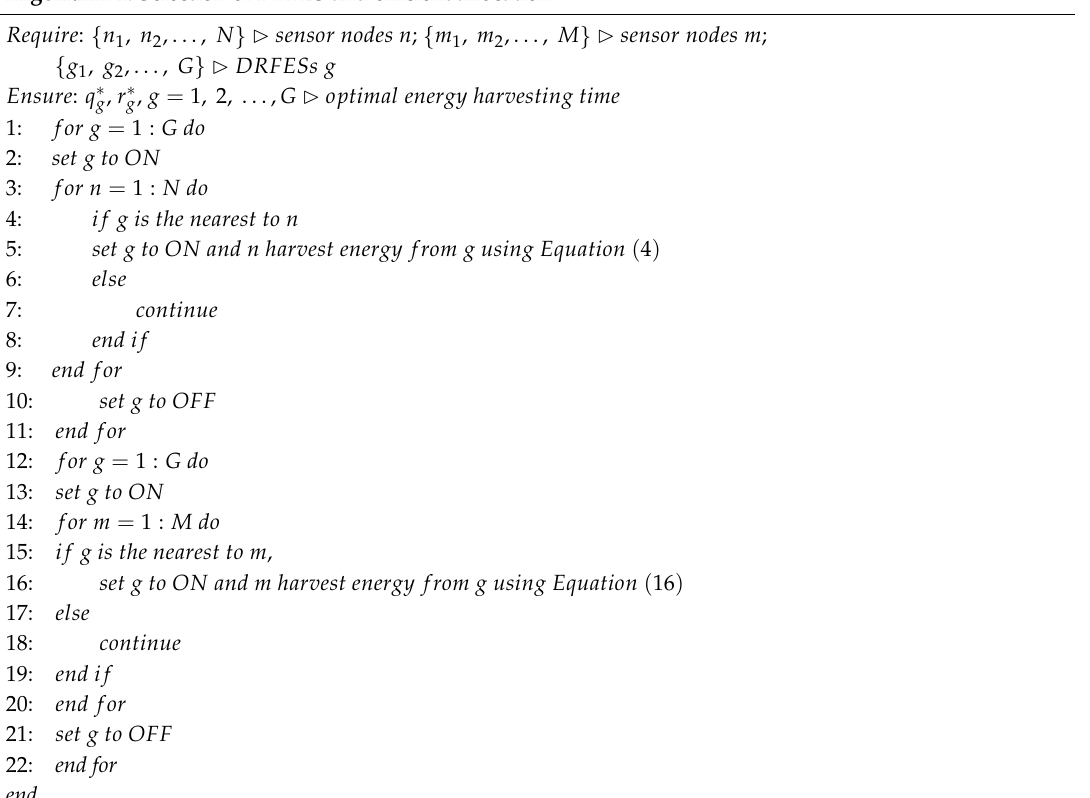
Algorithm 1. Selection of DRFES and efficient allocation.